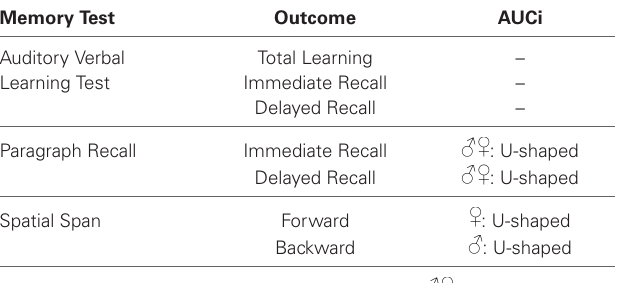
Table 1 | Short summary of the relationships found between basal memory test outcomes and cortisol AUCi in response to acute psychosocial stress .